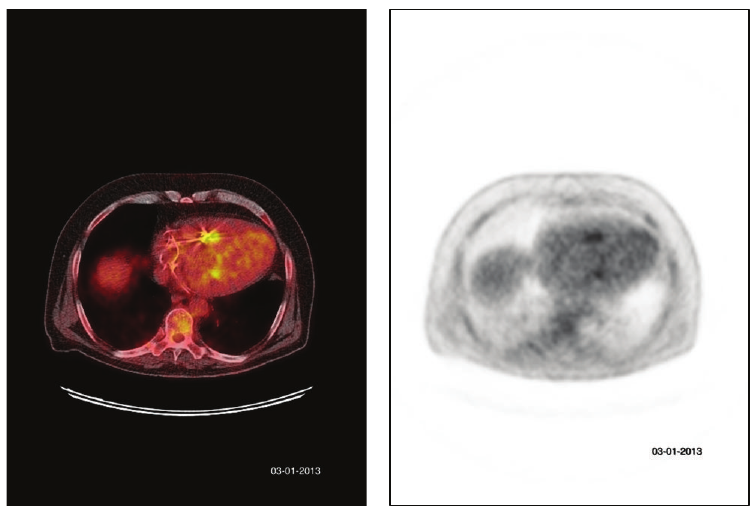
Figure 1: 18 F-FDG-PET scanning demonstrates pathologic activity by the tip of both